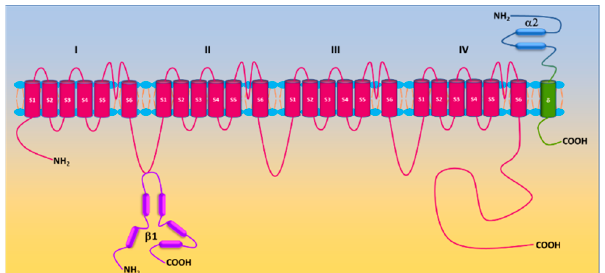
Figure 1. Topology of Ca v 1.2. Ca v 1.2 is formed by the pore-forming transmembrane α 1c subunit, the intracellular β -subunit, the extracellular α 2 subunit linked to the transmembrane δ 1 subunit in smooth muscle cells.